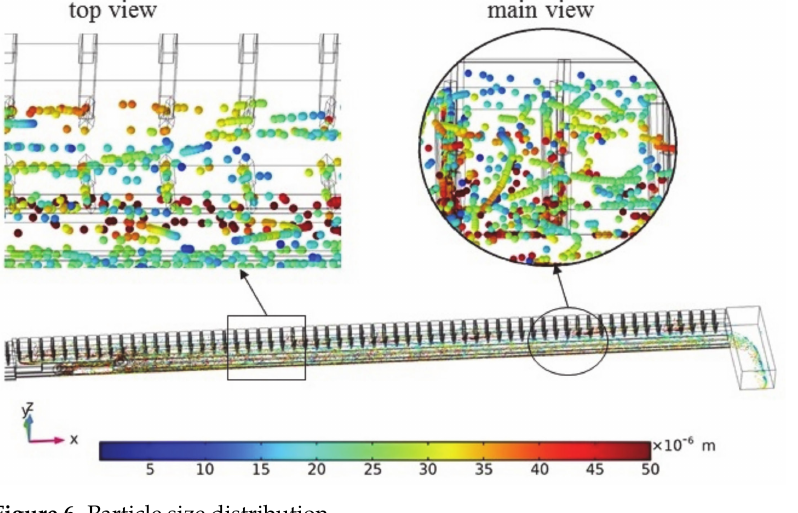
Figure 6. Particle size